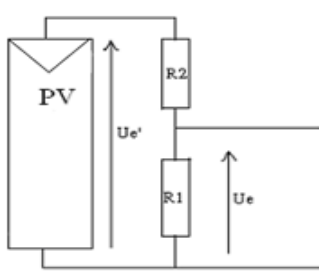
Figure 13. Voltage divider.